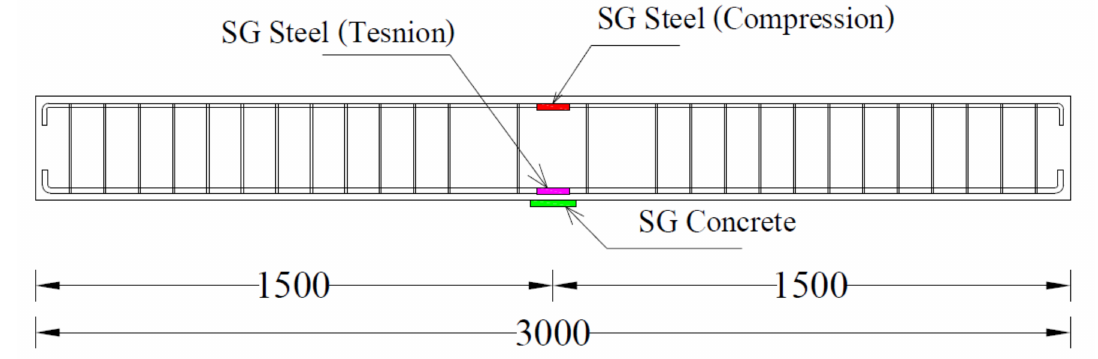
Figure 6. Load setup.